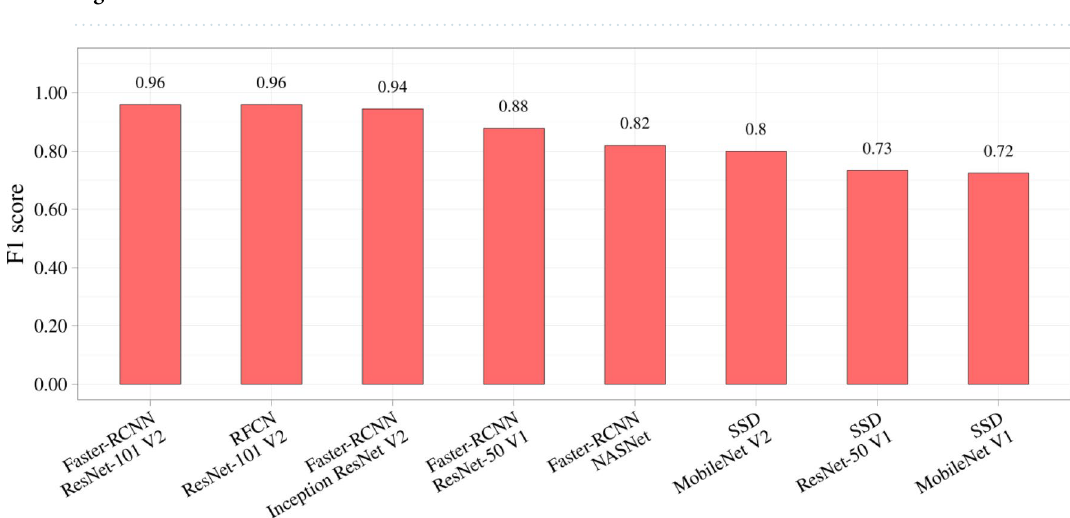
Figure 8. The F1 score of the selected neural network